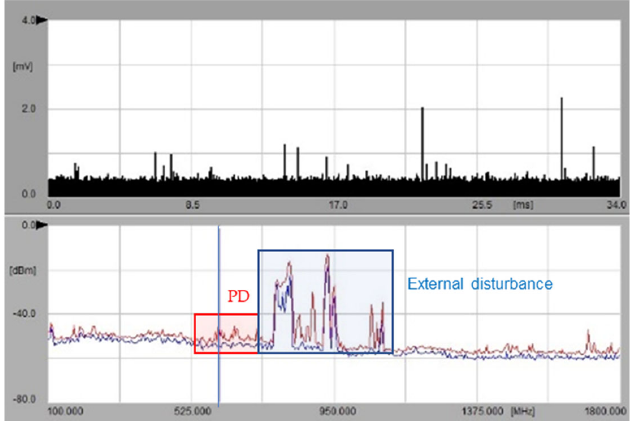
Figure 18. Frequency spectrum measured at the UHF sensor (black curve: PD signal in the time domain (zero span), blue curve: ground noise, red curve: PD signal, blue vertical marker at approxi- mately 610 MHz).